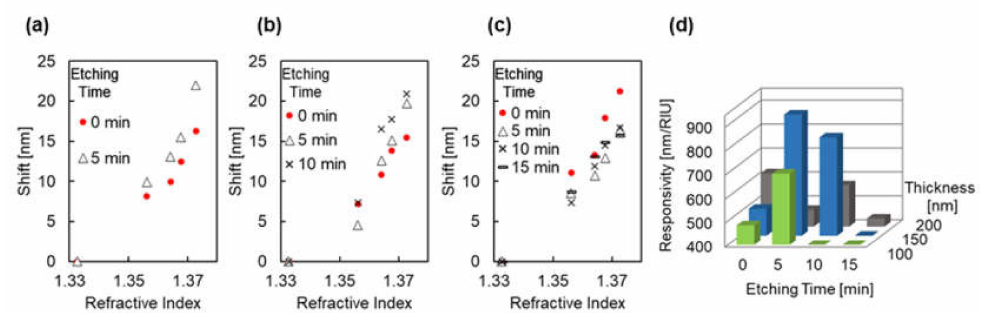
Figure 10. ( a – c ) Inflection point shifts due to refractive index changes under each fabrication condition for the plasmonic devices fabricated through depositing Au thicknesses of ( a ) 100 nm, ( b ) 150 nm, and ( c ) 200 nm. The red dots indicate an etching time of 0 min, the black hollow triangles indicate an etching time of 5 min, the black crosses indicate an etching time of 10 min, and the black horizontal lines indicate an etching time of 15 min. ( d ) The comparison of the responsivity of each plasmonic device with different fabrication